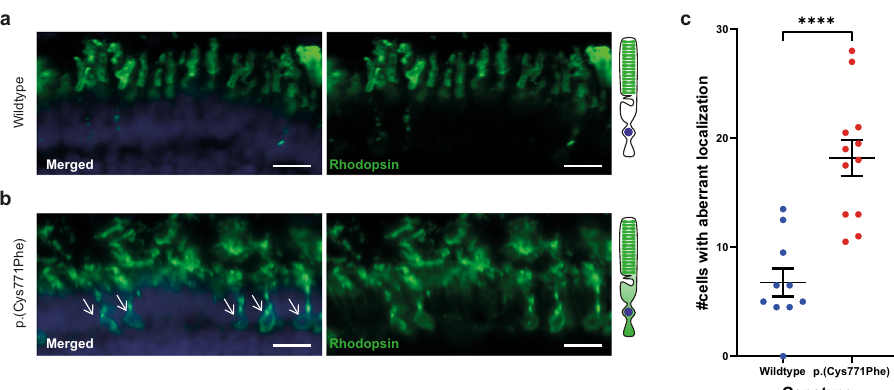
Fig. 4 Rhodopsin localization to the photoreceptor cell body in the ush2a p.(Cys771Phe) zebra fi sh. a Rhodopsin (green signal) localizes to the rod photoreceptor outer segments in wildtype larval eyes. A visual representation of a photoreceptor is shown on the right. b Aberrant localization of rhodopsin to the photoreceptor cell body was observed in ush2a p.(Cys771Phe) larvae (indicated by white arrows), which was observed in a signi fi cantly higher number of photoreceptors of ush2a p.(Cys771Phe) larvae as compared to wildtype larvae ( c ; unpaired t test). Nuclei are stained with DAPI (blue signal). Scale bar: 10 µM. **** p < (unpaired Student ’ s t test (two-tailed); p < 0.0001; t: 5.318, df: 20) models 31 , we also investigated the localization of rhodopsin in our (Fig. 4). Finally, ERG responses were recorded for both wildtype ( n = 38 from three biological replicates) and p.(Cys771Phe) ( n = 36 from ( n = 12 eyes of 6 larvae). We observed a signi fi cant increase in the three biological replicates) larvae at 5 dpf. A signi fi cant decrease in number of photoreceptor cells with aberrant rhodopsin localization maximum B wave amplitudes (~11%) was observed in the in ush2a p.(Cys771Phe) as compared to matched wildtype controls